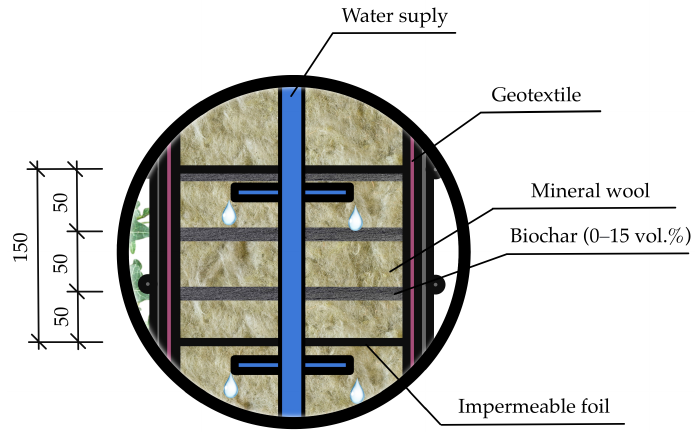
Figure 1. Vertical greenery systems (VGS) panel, all dimensions in mm.